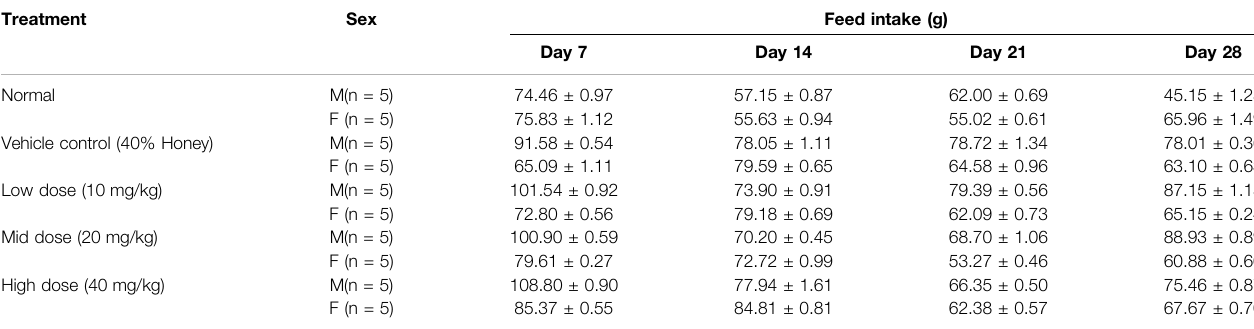
TABLE 2 | Effect of in-house Thamira parpam on feed intake. Treatment